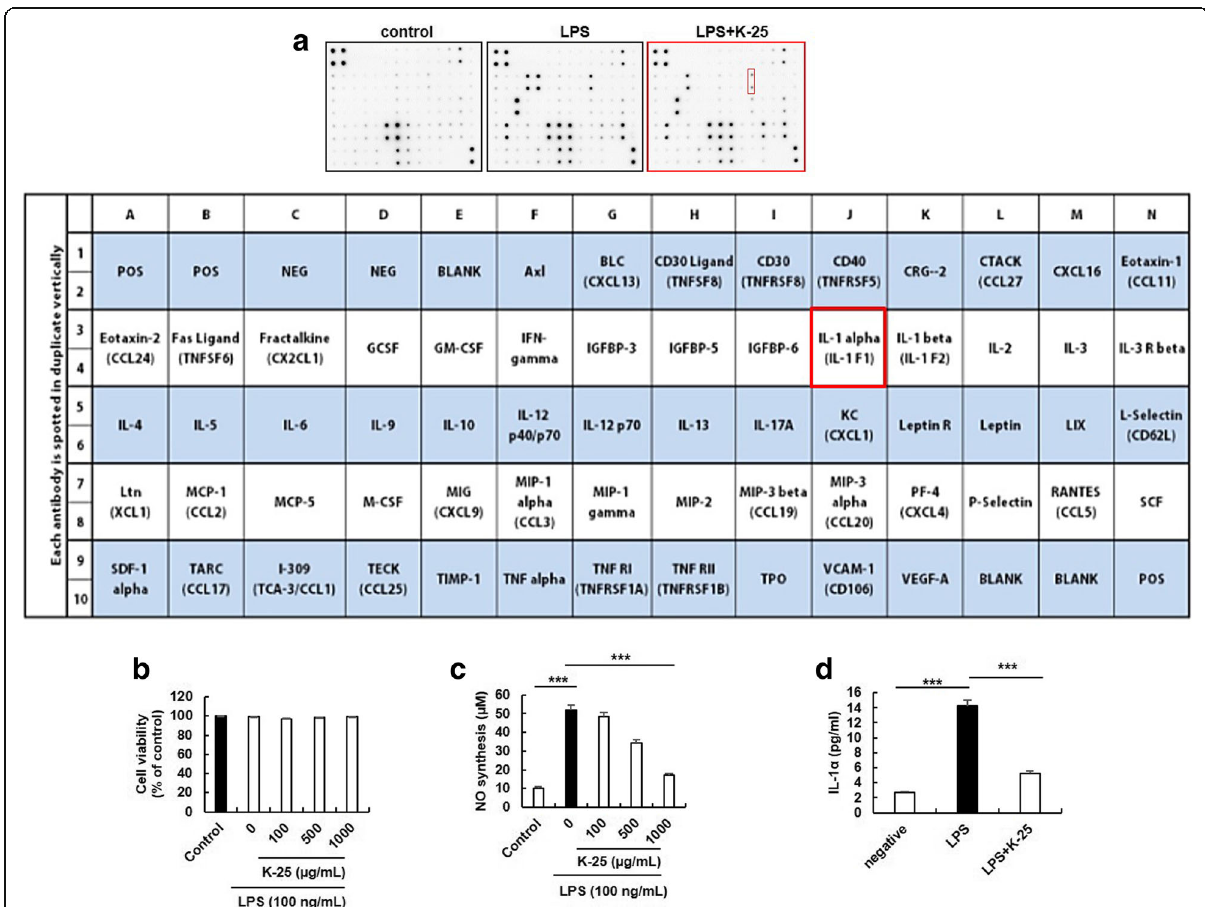
Fig. 2 Inhibition of LPS-induced NO production and IL-1 α secretion by K-25. Raw 264.7 cells were pretreated with various concentrations of K-25 for 1 h before LPS (100 ng/mL) treatment. a After 24 h-incubation, the cultures were subjected to cytokine antibody array assay. b After 24 h- incubation, cell viability was measured using the EZ-cytox assay kit. c After 24 h of incubation, NO production was measured using the Griess Reagent System assay. d After 24 h-incubation, the culture medium was assayed using ELISA for IL-1 α . Values represent mean ± standard error of the mean. ** p < 0.01, compared to the LPS control. The statistical significance (* p < 0.05, ** p < 0.01, *** p < 0.001) was determined using ANOVA with Bonferroni